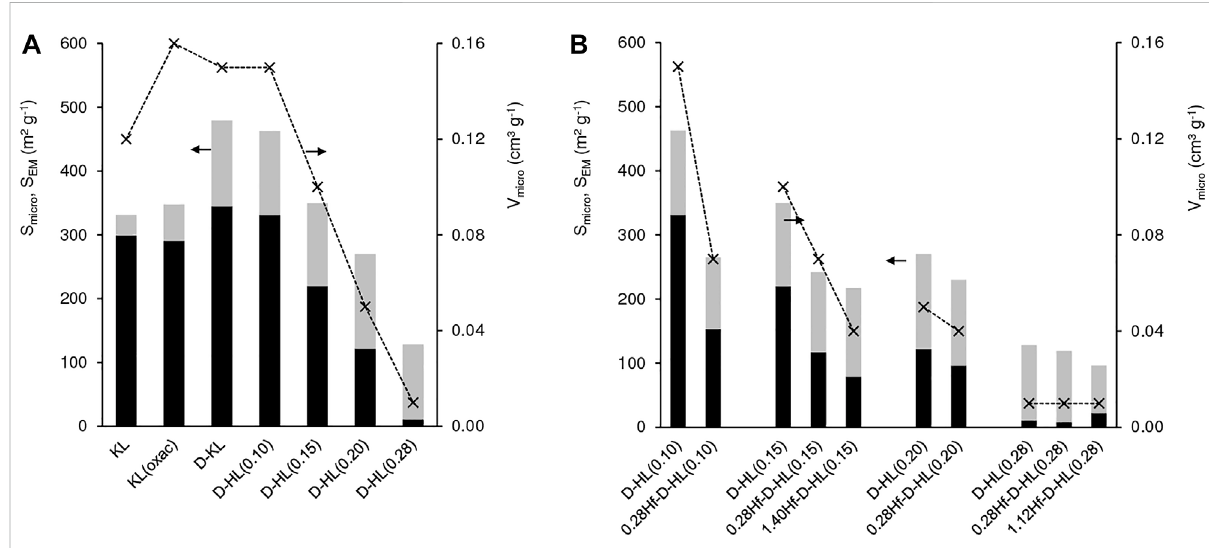
FIGURE 4 Textural properties of (A) KL, KL(oxal), D-KL and D-HL(x), and of (B) D-HL(x) and yHf-D-HL(x) materials prepared: micropore speci fi c surface area(S micro (blackbars)),external/mesoporespeci fi csurfacearea(S EM (greybars))andmicroporevolume(V micro